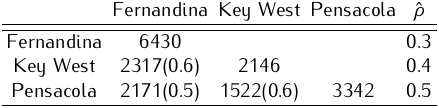
Table 3. Variances, covariances (mm 2 ) and correlations (within parentheses) among three station residuals. Autoregres- sive residual correlation coefficient ˆ ρ for each station is also